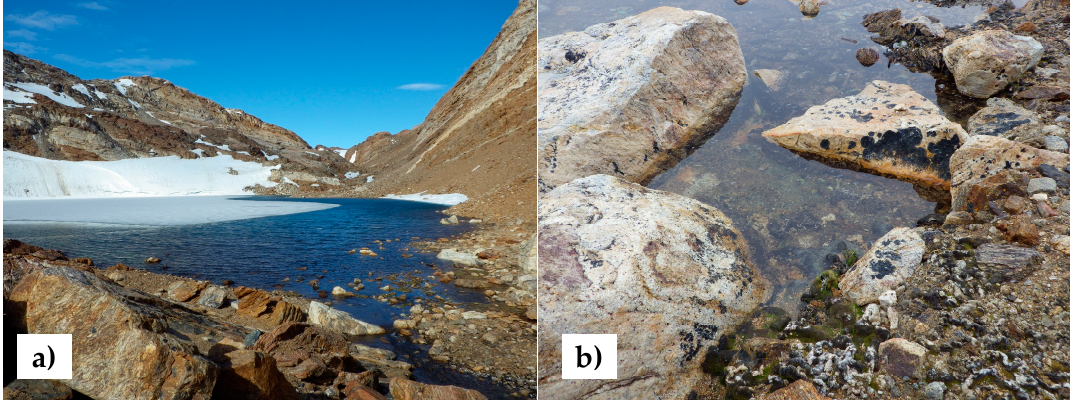
Figure 1. Lake Yukidori-Ike ( a ) and a sampling point ( b ).